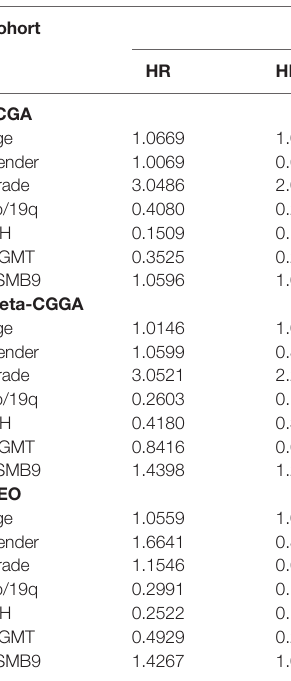
TABLE 2 | Univariate and multivariate Cox regression